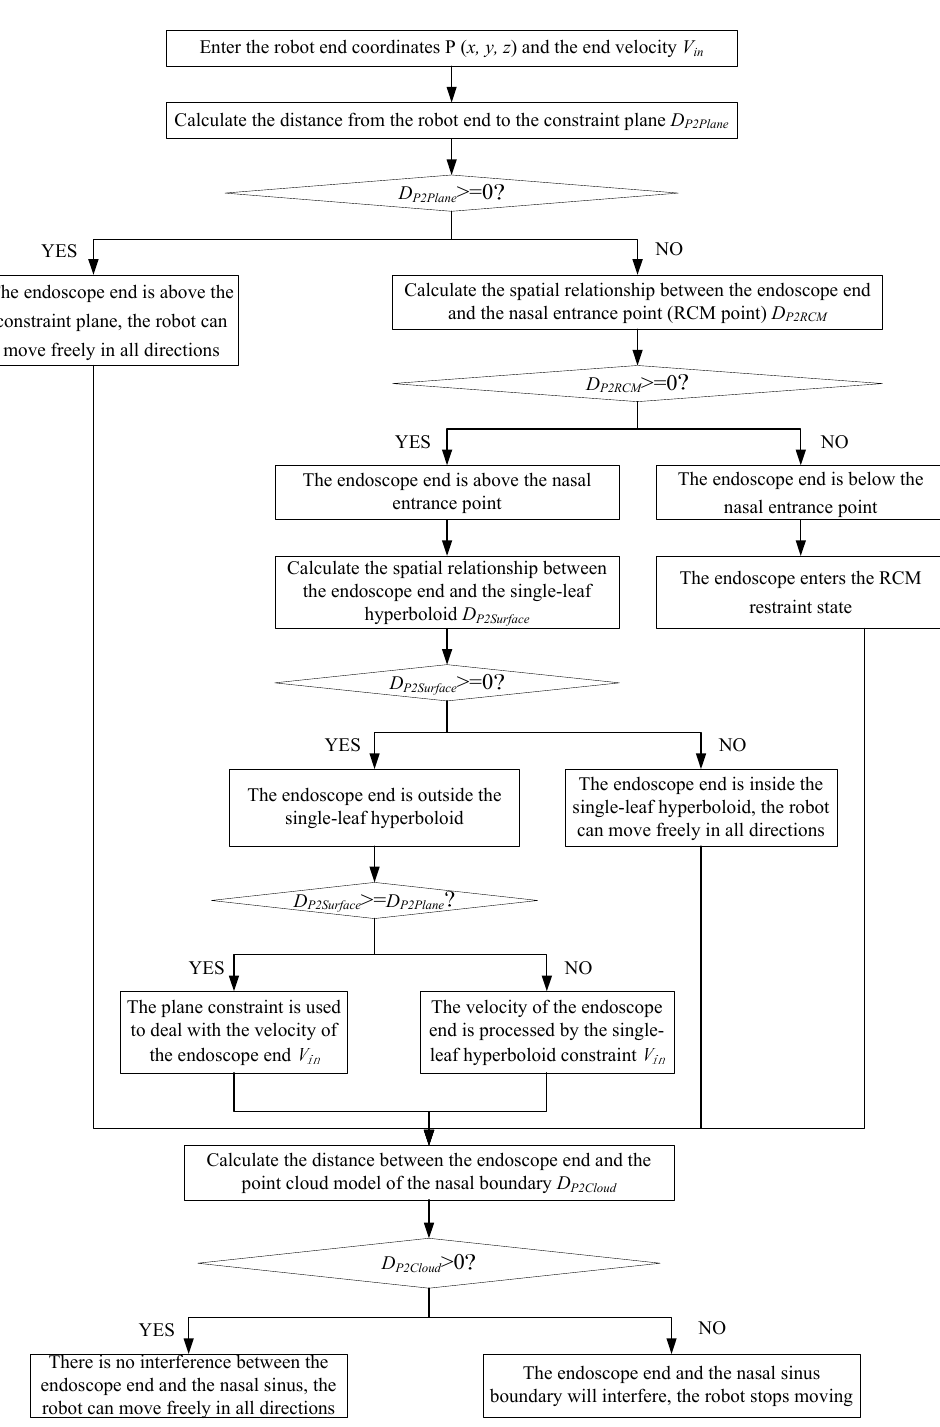
Figure 6. The process of the composite VF.